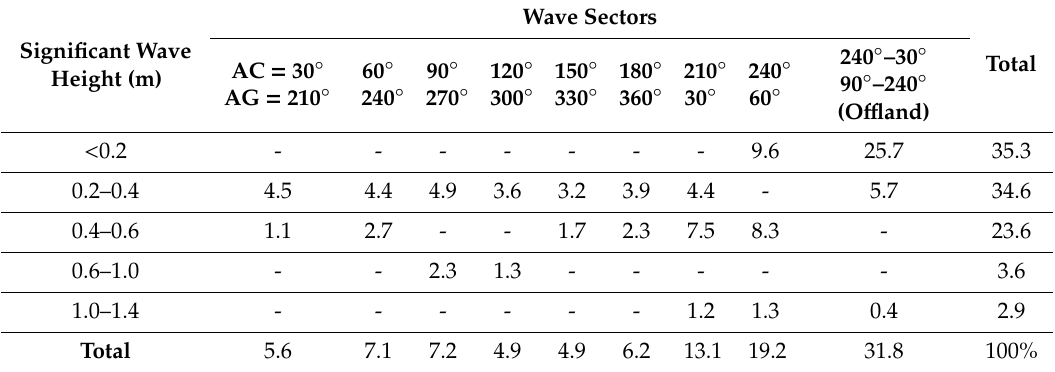
Table 1. Annual wave data in depth of 20 m at transect 20 based on SWAN (excluding extreme storms).